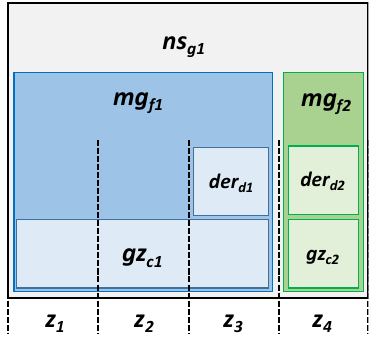
Figure 3. Nomenclature diagram for a selected Network Solution.